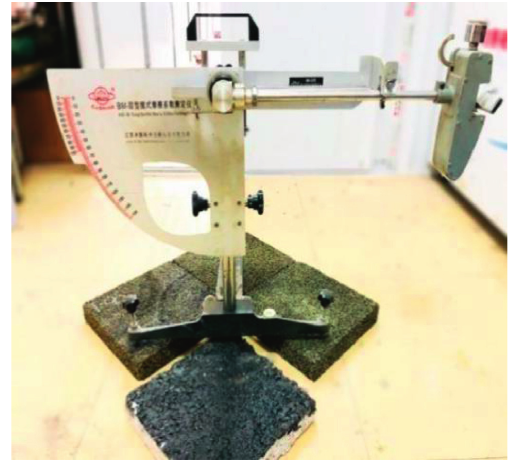
Figure 7: British pendulum tester.